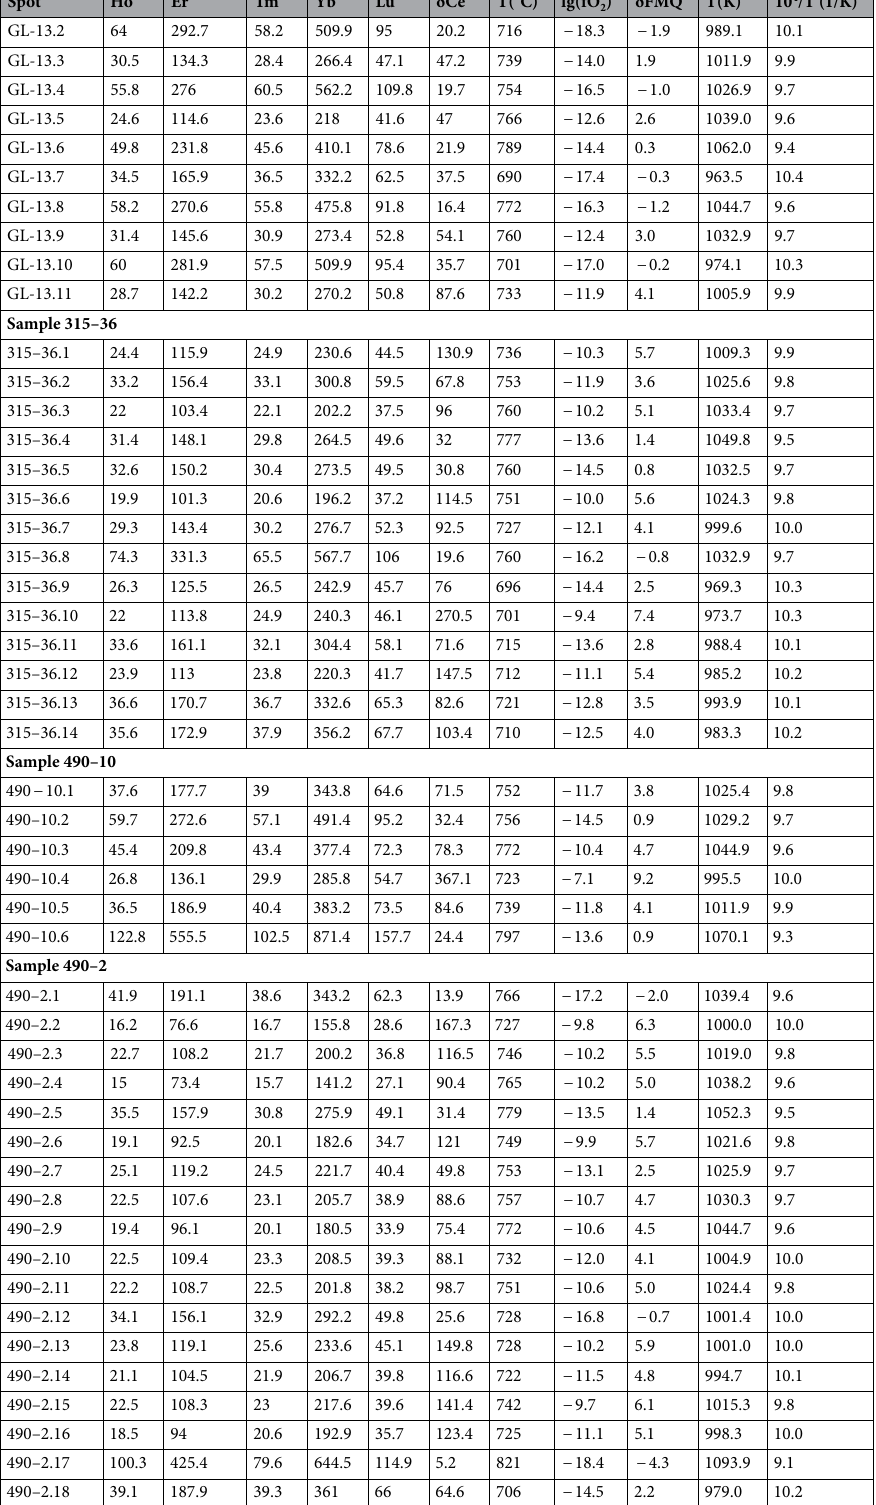
Table 2. Zricon Trace element compositions, Ce anomalies, and Ti-in-zircon temperatures. Notes: Ce anomalies (δCe) are calculated based on Nd, Sm, and Gd to Lu using the lattice strain model (Blundy and Wood, 1994) 55